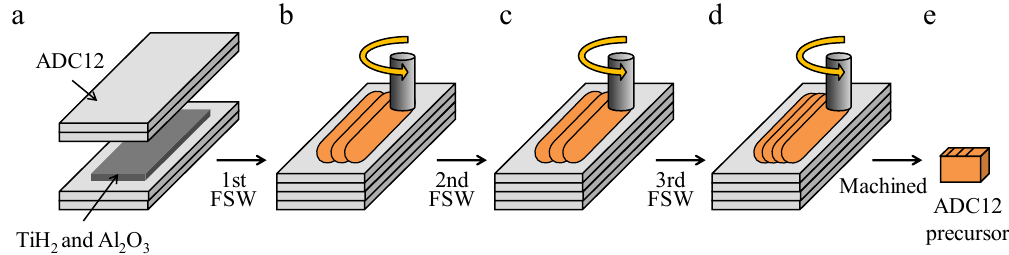
Figure 12. Schematic illustration of fabrication process of ADC12 Al foam precursor using FSW route.